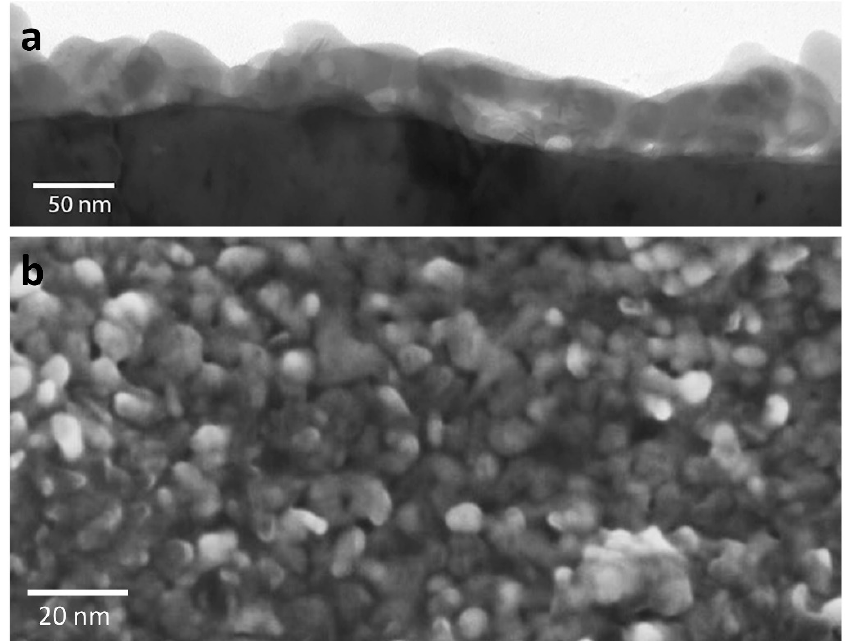
Figure 3. Corrosion layer formed on bulk silver imaged with ( a ) transmission electron microscopy (TEM) in cross-section and ( b ) scanning electron microscopy of the surface. This corrosion layer was one that had formed after many years of exposure to ambient air and can be seen to be particulate in nature.